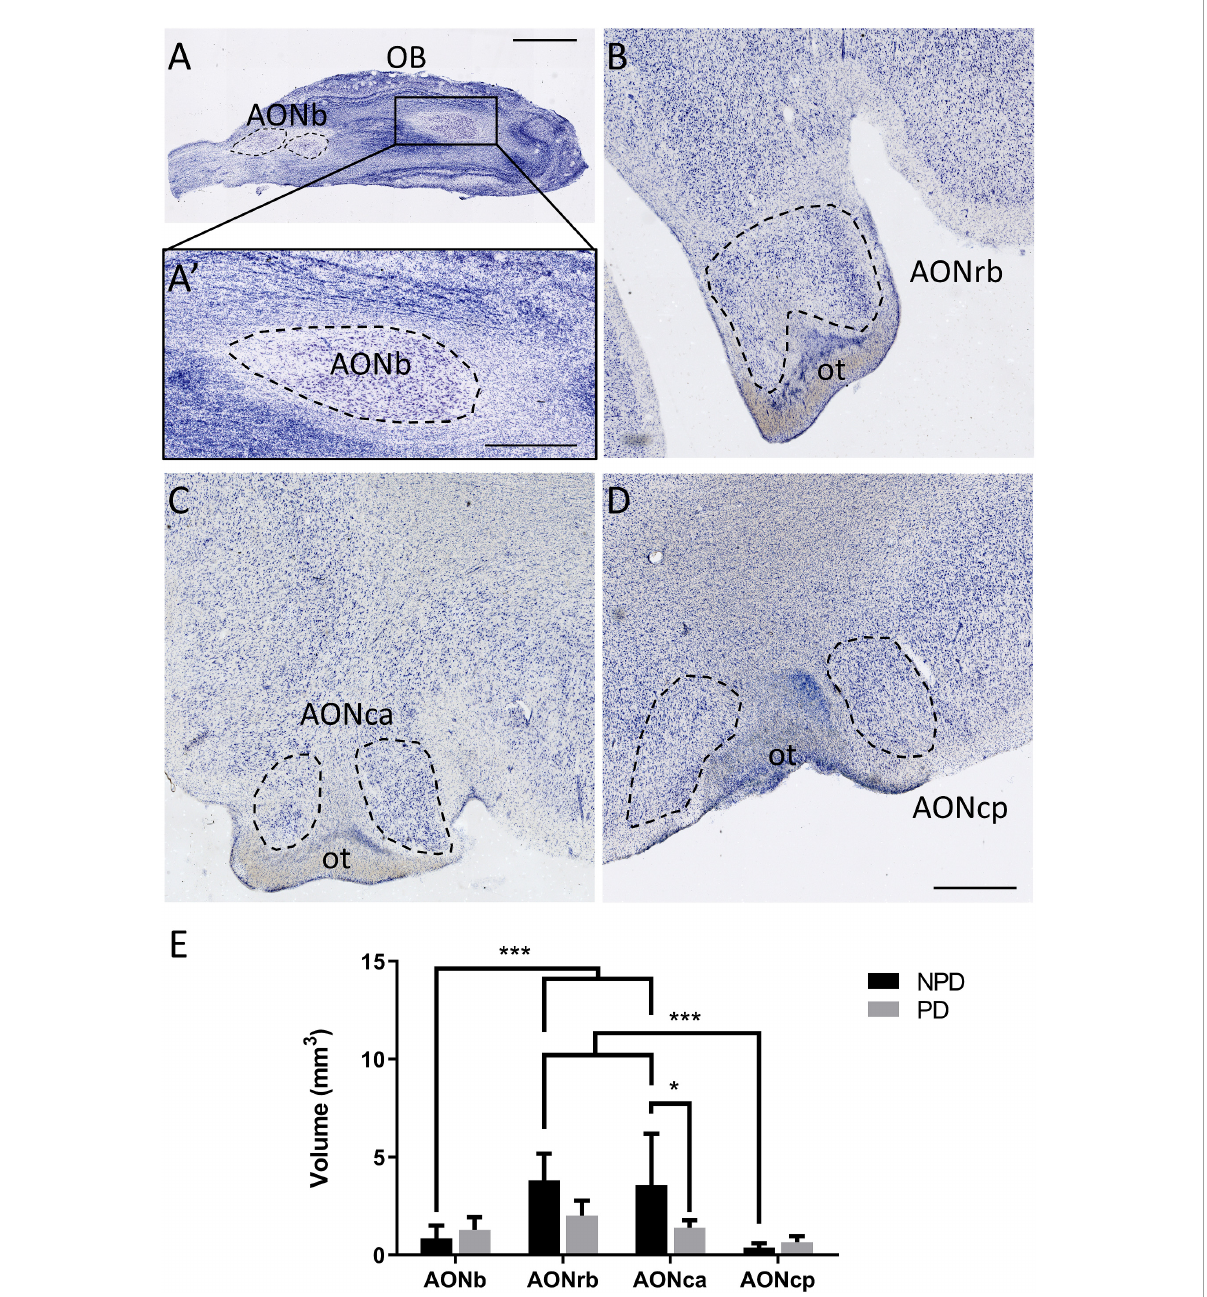
FIGURE1 Anterior olfactory nucleus cytoarchitecture and volume. Mosaic reconstruction of Nissl-stained sections of human AON and its volumetric analysis. Horizontal section of the olfactory bulb (A) . The frame in panel (A) indicates AONb (A’) . Coronal section of the cortex in which the dashed line shows AONrb (B) , AONca (C) , and AONcp (D) , and “ot” indicates the olfactory tract. The mean ± SD of volume AON portions in PD and NPD cases (E) . * P -value <0.05 and *** P -value <0.001. Scale bar = 2,000 mm (A) , 1,000 mm (A’) , and 500 mm (B–D) .